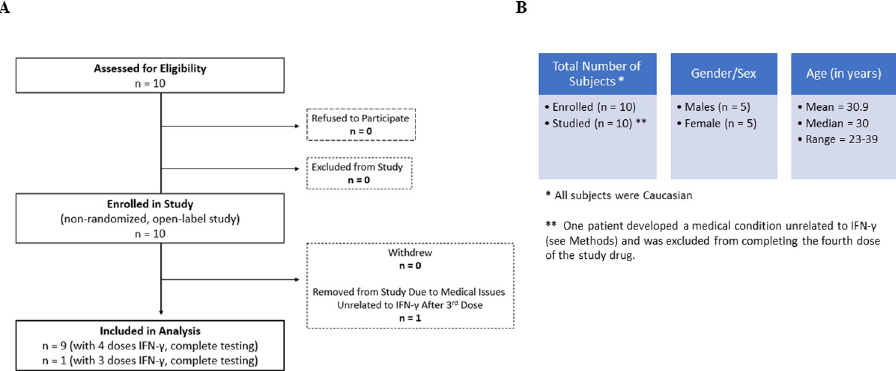
Fig 1. A. Flow diagram showing recruitment, enrollment, and analysis in the clinical trial and B. Demographics for the patients enrolled in the